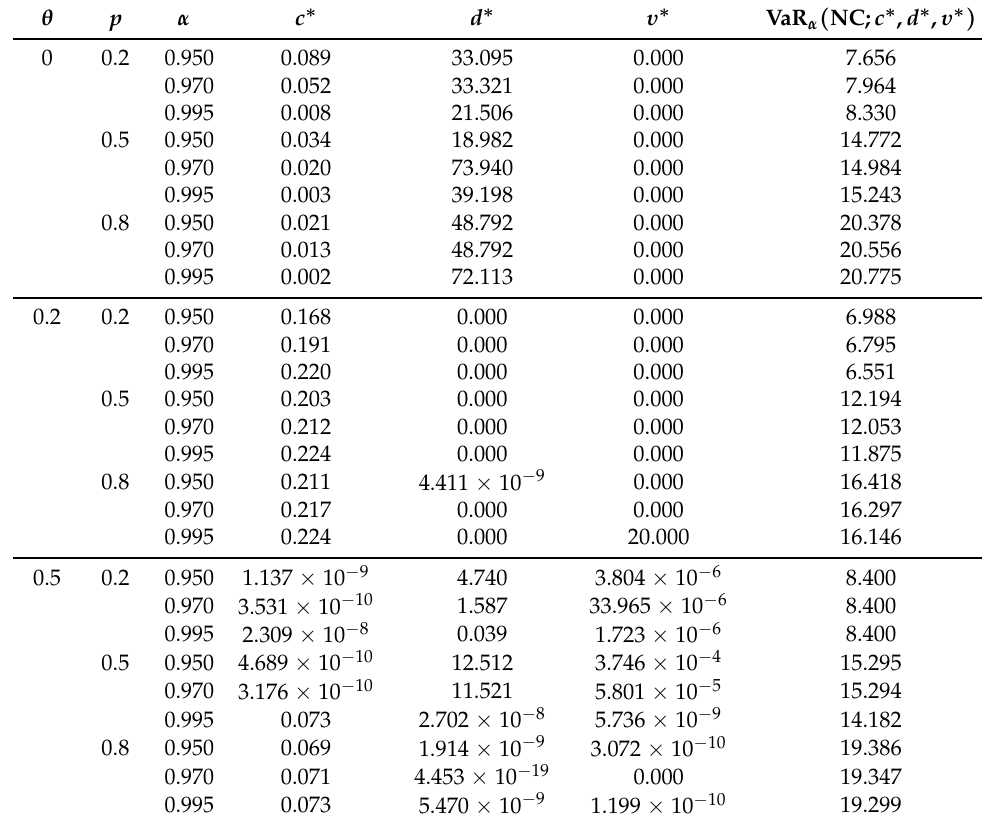
Optimal combination of proportional and stop-loss reinsurance and the resulting VaR α ( NC; c ∗ , d ∗ , υ ∗ ) for Case 2 under the